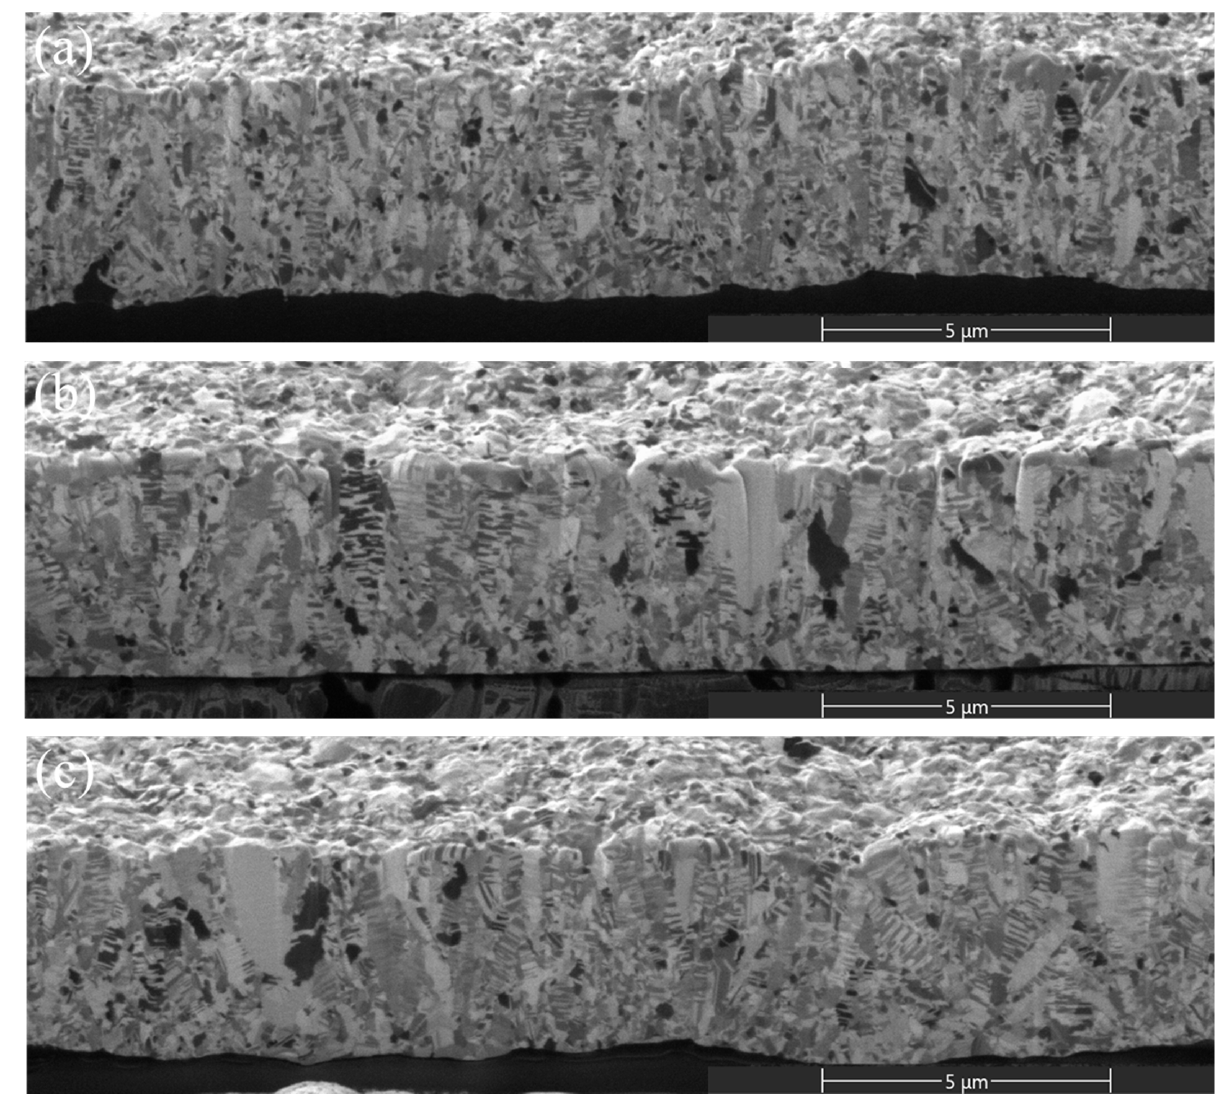
Figure 2. Cross-sectional FIB micrographs of the 5- μ m thick nt-Cu foils electroplated with different concentrations of Cu 2+ : ( a ) 0.3 M; ( b ) 0.5 M; ( c ) 0.8 M.